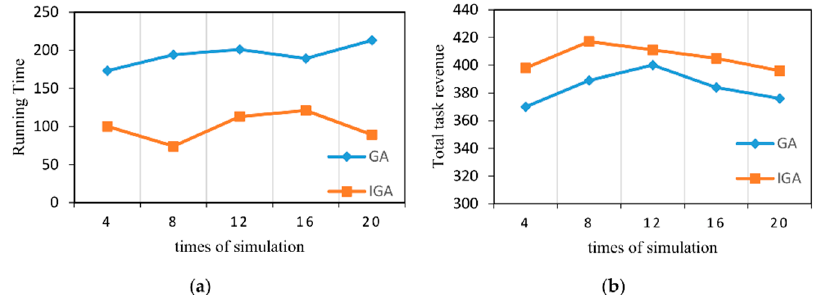
Figure 13. The result of Experiment 4. ( a ) The running time of Experiment 4 and ( b ) the task revenue of Experiment 4.